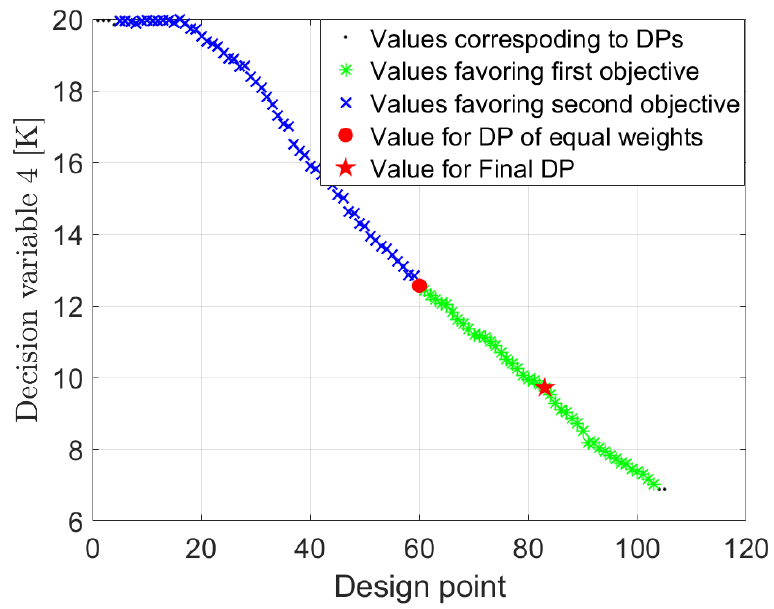
Figure 8. Graph generated at the end of the decision-making process: scatter distribution of the decision variable with marked decisions.